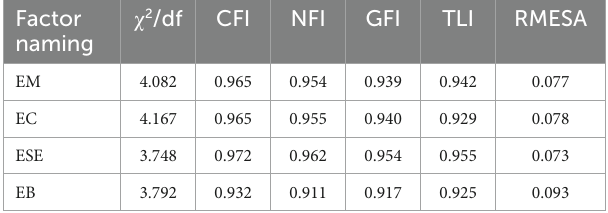
TABLE 2 Confirmatory factor analysis